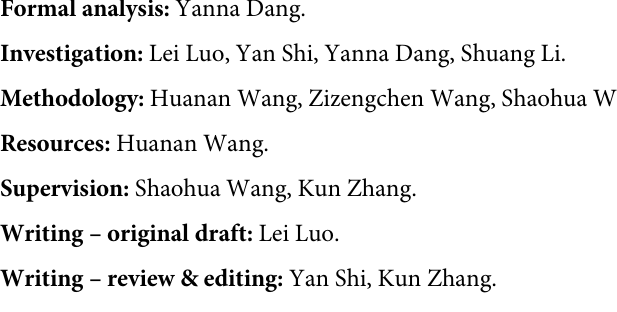
S1 Table. The synthesis of sgRNAs sequence. S2 Table. The primers information of sgRNA template for in vitro transcription. S3 Table. Nested PCR primer sequences for preparing Sanger sequencing samples. S4 Table. The predicted potential 6 off-target sites for SMAD4 . S5 Table. PCR primer sequences for preparing targeted next generation sequencing sam- ples. S6 Table. Antibody